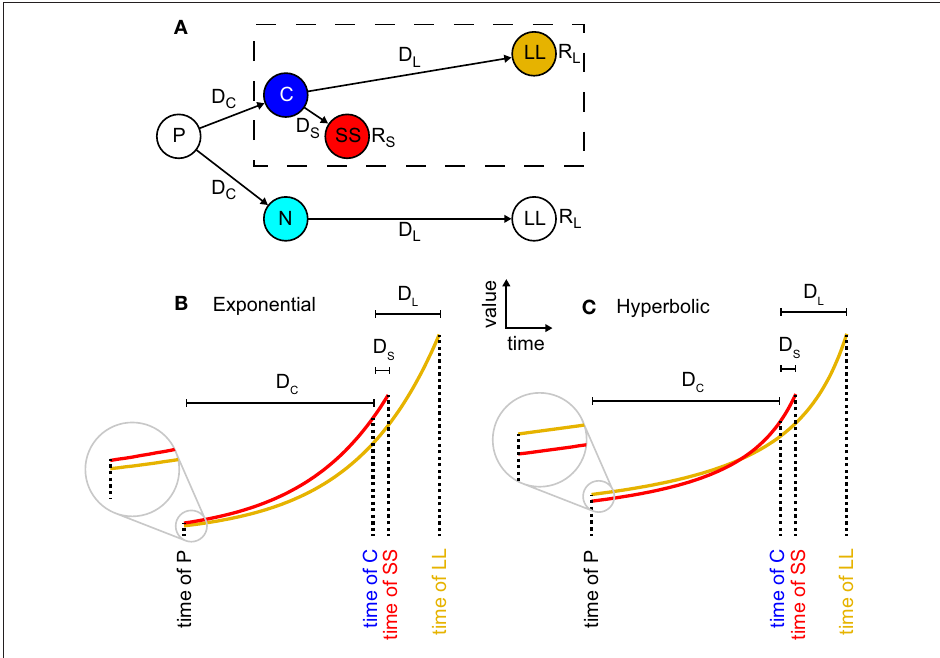
Figure 1 | Precommitment arises from hyperbolic but not exponential discounting. (A) A state-space for precommitment (from Kurth-Nelson and Redish, 2010). The agent first chooses whether to enter state C or state N. From state C, a standard intertemporal choice is available, between a larger reward available later (LL) and a smaller reward available sooner (SS). This choice is outlined with a dashed box. But from state N, only LL is available. Thus choosing N represents precommitment. (B) In exponential discounting, values decay by the same percentage for each unit of delay, so if SS is preferred at state C, it must also be preferred at state N. (C) , In hyperbolic discounting, values decay more steeply proximally to the outcome, so it is possible for SS to be preferred at state C, but for LL to be preferred at state